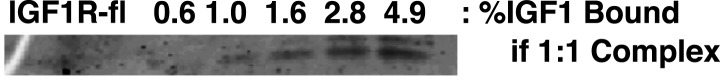
IGF1 does not co-purify with IGF1R-fl.To investigate if IGF1 from the growth medium co-purified with IGF1R-fl, we compared a fixed amount of the purified receptor sample to known quantities of purified IGF1 by Sypro-Ruby stained SDS-PAGE. For lanes containing the IGF1 standards, the percentage of a one IGF1 to one receptor complex equivalent to the amount of IGF1 loaded in that lane is marked above. Therefore, >99.4% of the IGF1R-fl protein purified is unliganded.